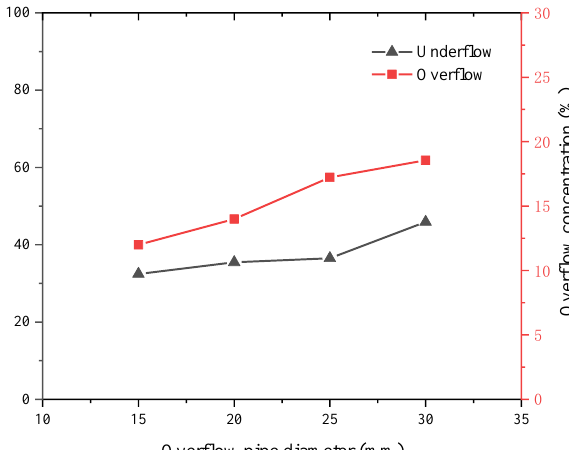
Figure 14. The yield and split ratio.